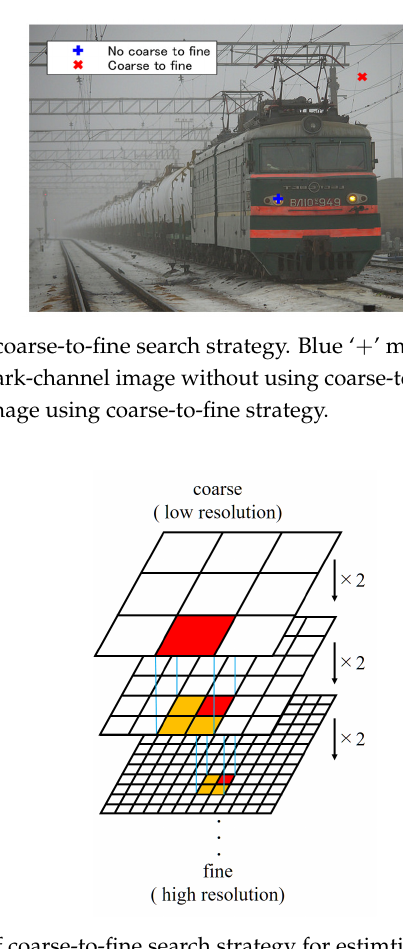
Figure 6. Flow of coarse-to-fine search strategy for estimting atmospheric light A